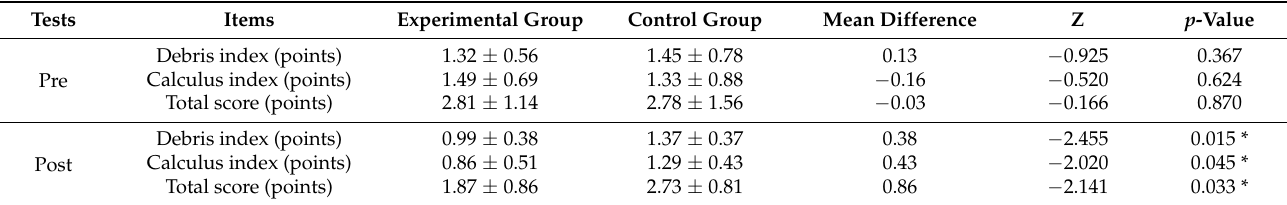
Table 6. The results of oral hygiene between 2